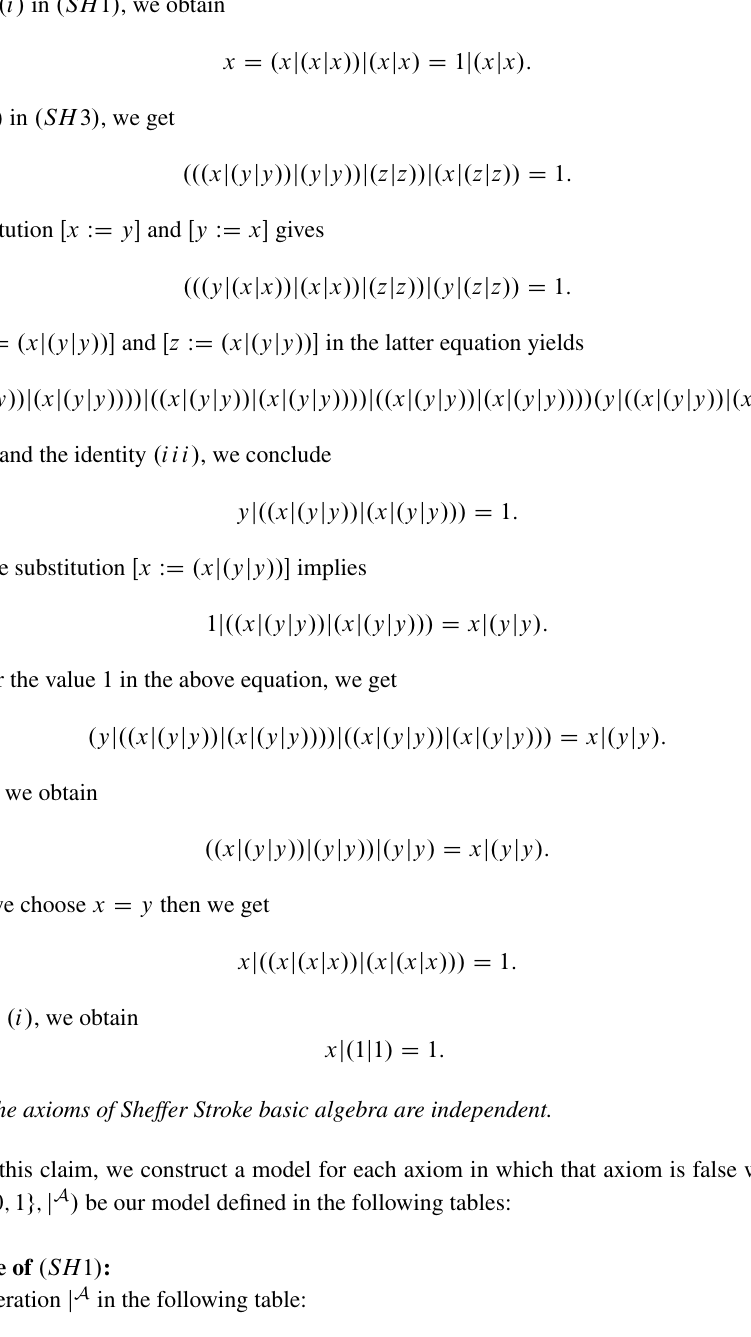
Table 1. Operation Table for Independence of